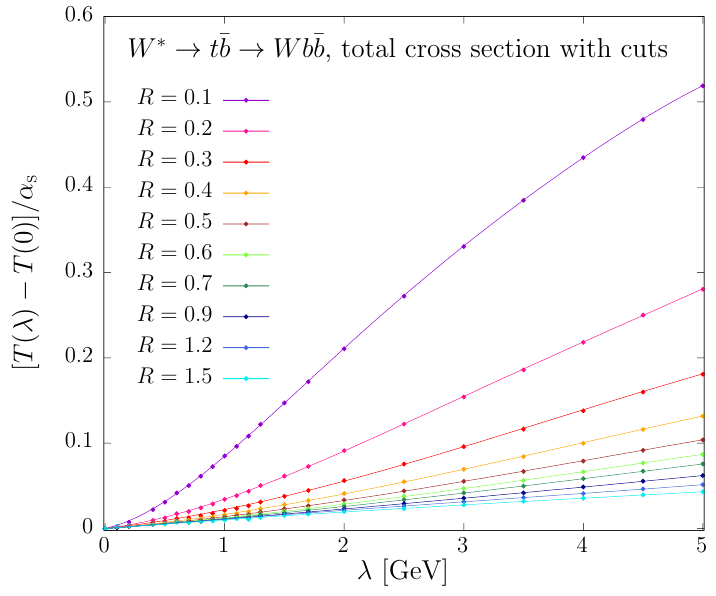
Figure 4 . Small (cid:21) behaviour for T ( (cid:21) ) for the inclusive cross section with cuts, for several jet radii. The points are obtained with our numerical calculations, while the solid lines represent their polynomial (cid:12)t. The (cid:12)tting functions are order 5, 4 and 3 polynomials for R = 0 : 1, R = 0 : 2 and R (cid:21) 0 : 3 radii